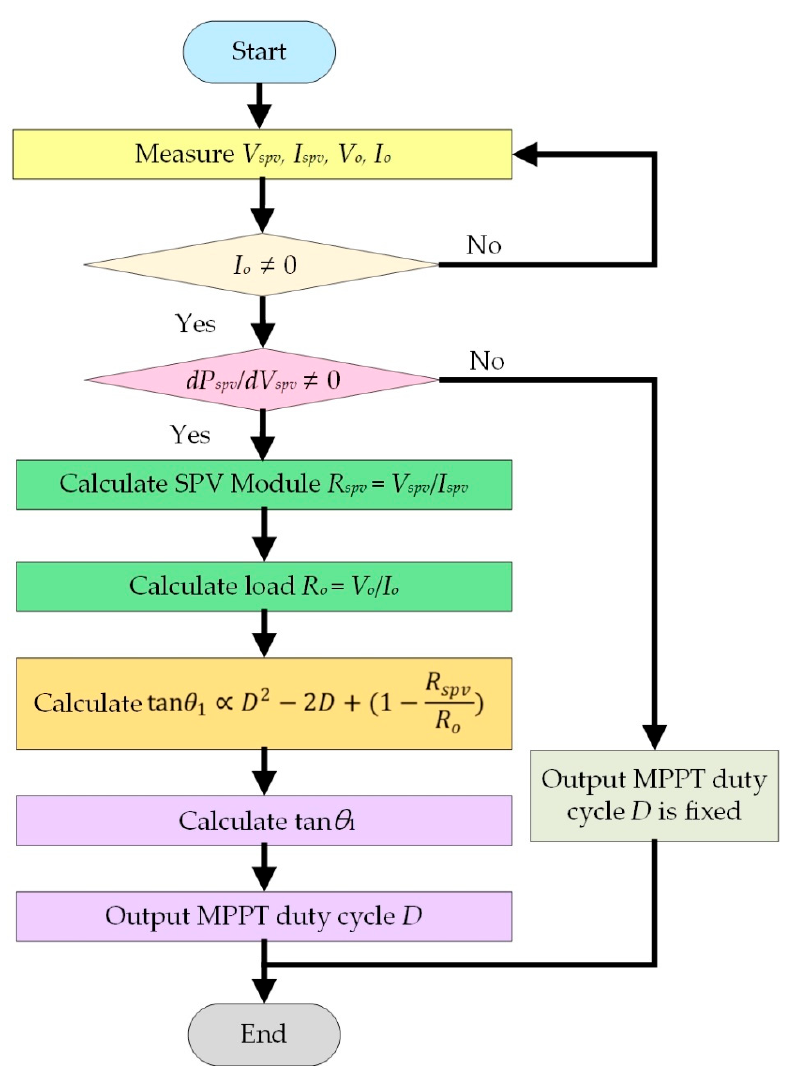
Figure 10. Flowchart of the proposed SLOPDM MPPT control strategy.